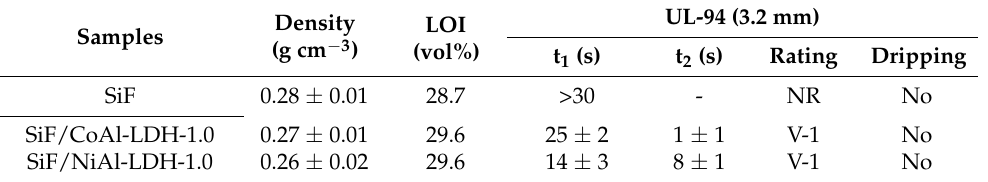
Table 2. The results of the density, LOI value, and vertical flame testing.